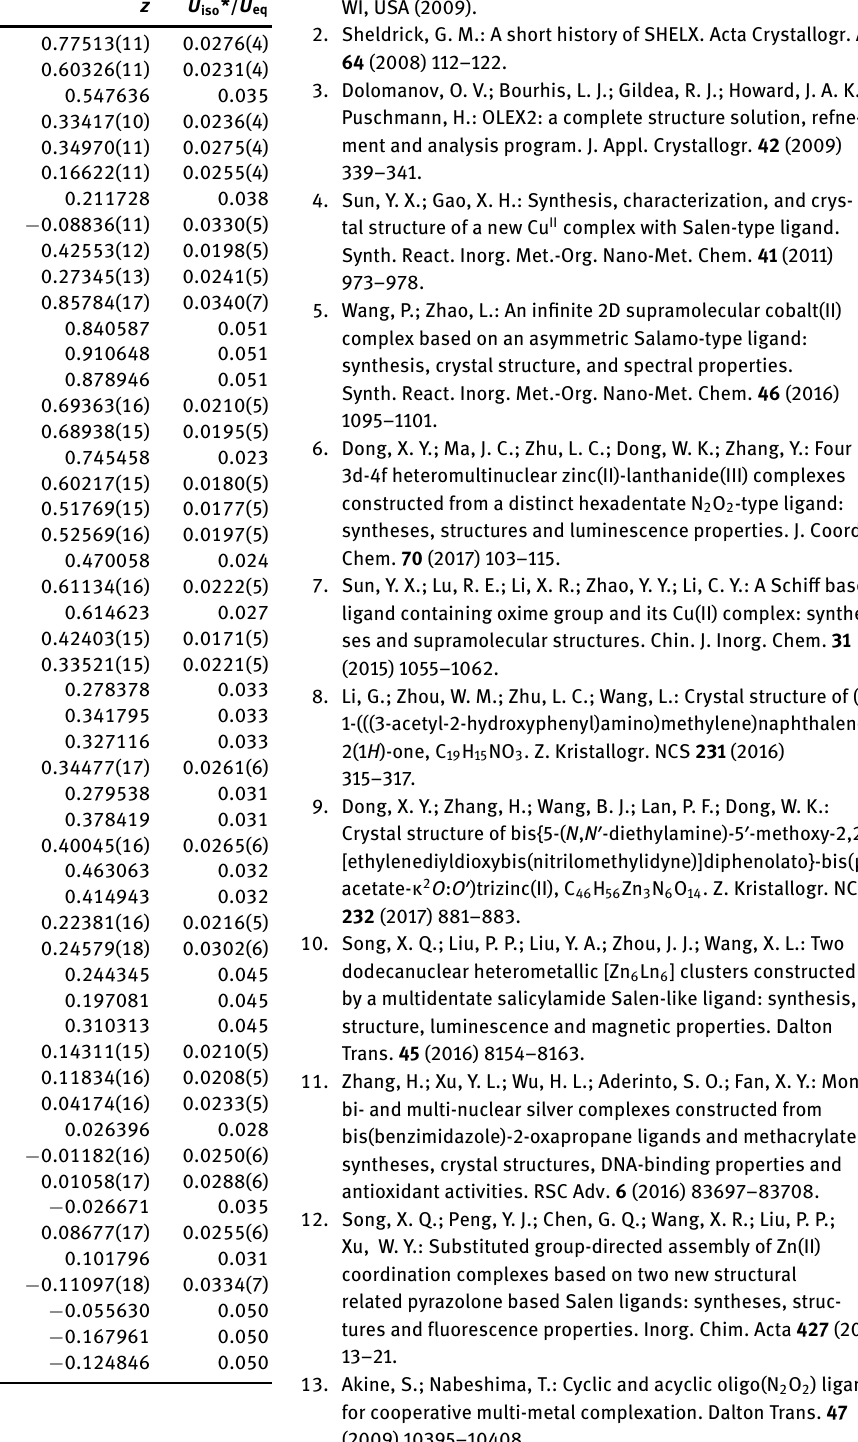
Table 2: Fractional atomic coordinates and isotropic or equivalent isotropic displacement parameters (Å 2